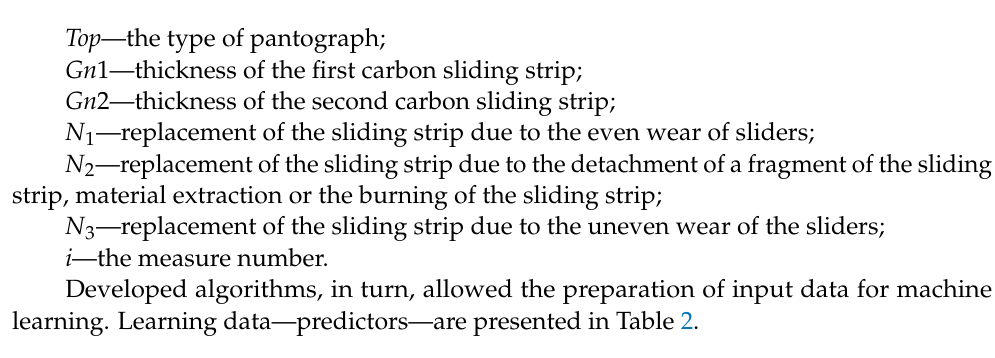
Table 2. Machine learning